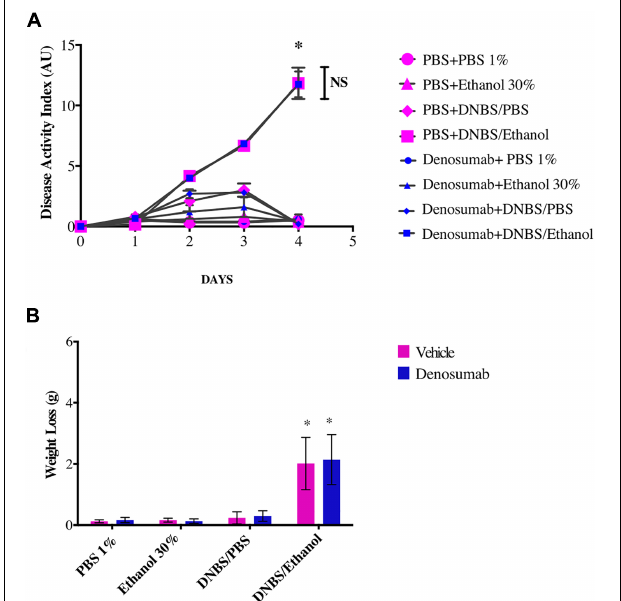
FIGURE 2 | The effects of DNBS/Ethanol-induced colitis and denosumab treatment on (A) . Disease activity index, and (B) . Weight loss. Vehicle = PBS 1%. Error bars are shown as SEM. * p < 0.001 when compared with other induction models within the denosumab or vehicle group calculated using SAS MIXED procedure and illustrated by Prism using two-way ANOVA. NS: no significant difference between denosumab treatment and DNBS/Ethanol-induced colitis. n = 6 mice per group. AU: arbitrary